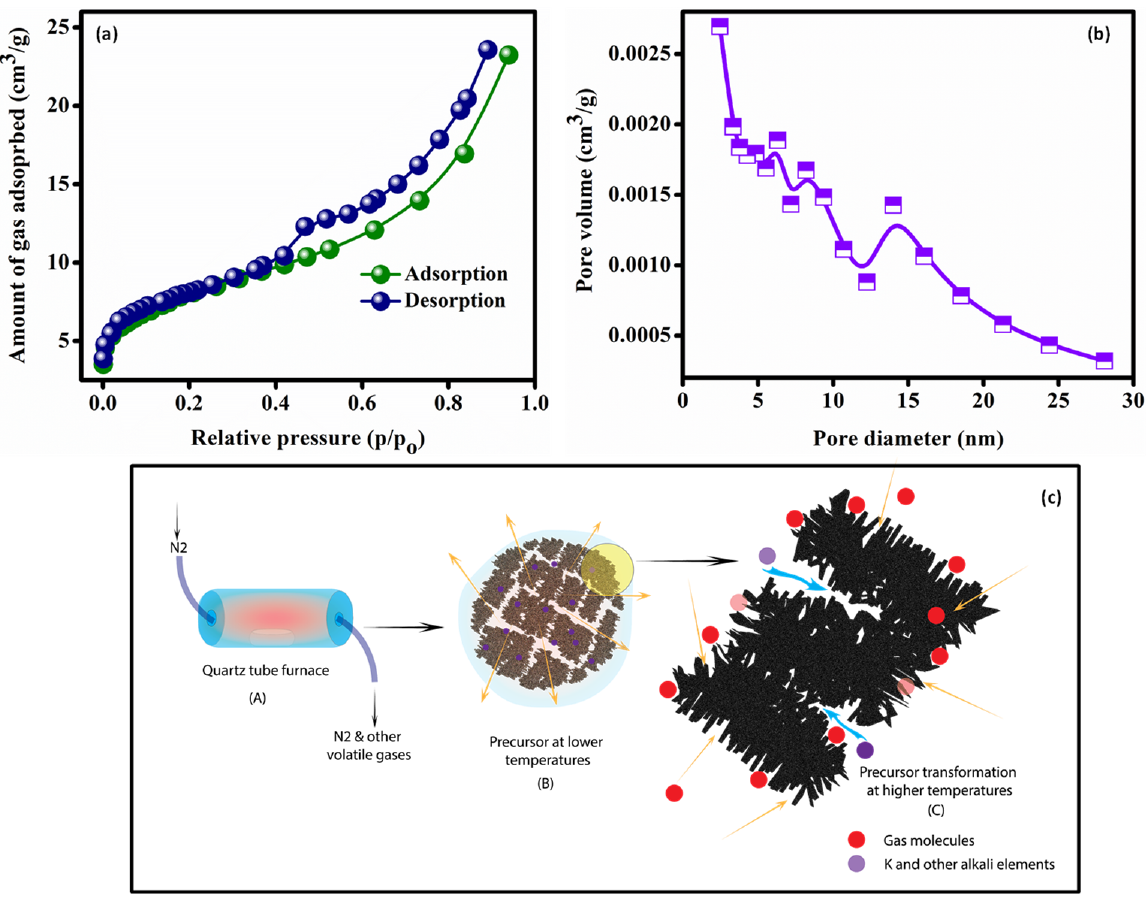
Figure 2. N 2 adsorption desorption isotherms for the OPL 1000 sample ( a ). Pore size distribution for the OPL 1000 sample ( b ). Schematic illustration of the CNS synthesis process ( c ).